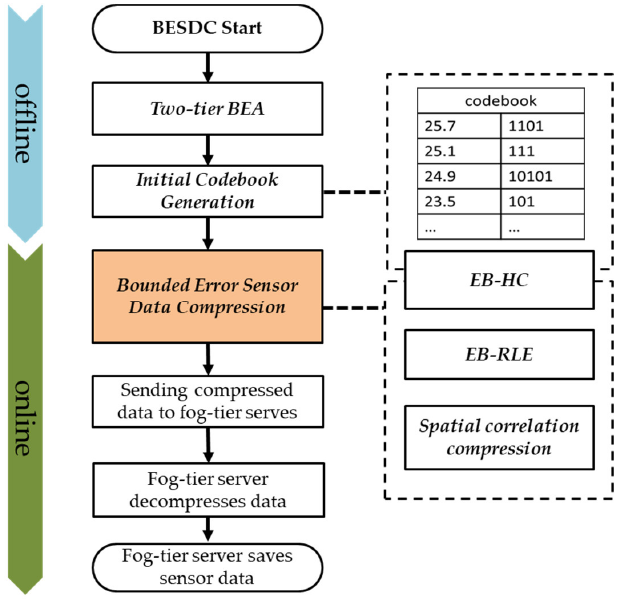
Figure 2. The processing flow of our proposed BESDC scheme.